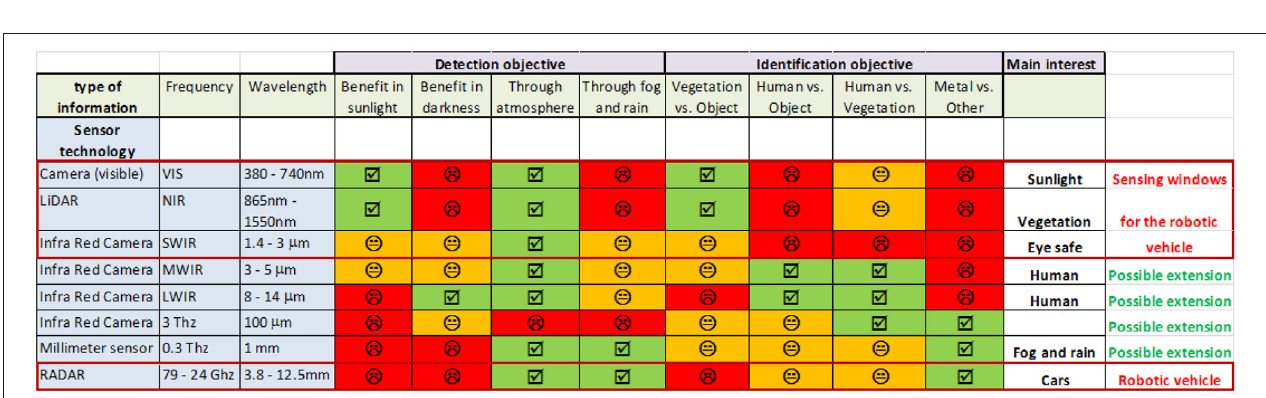
Frontiers in Sustainable Cities |